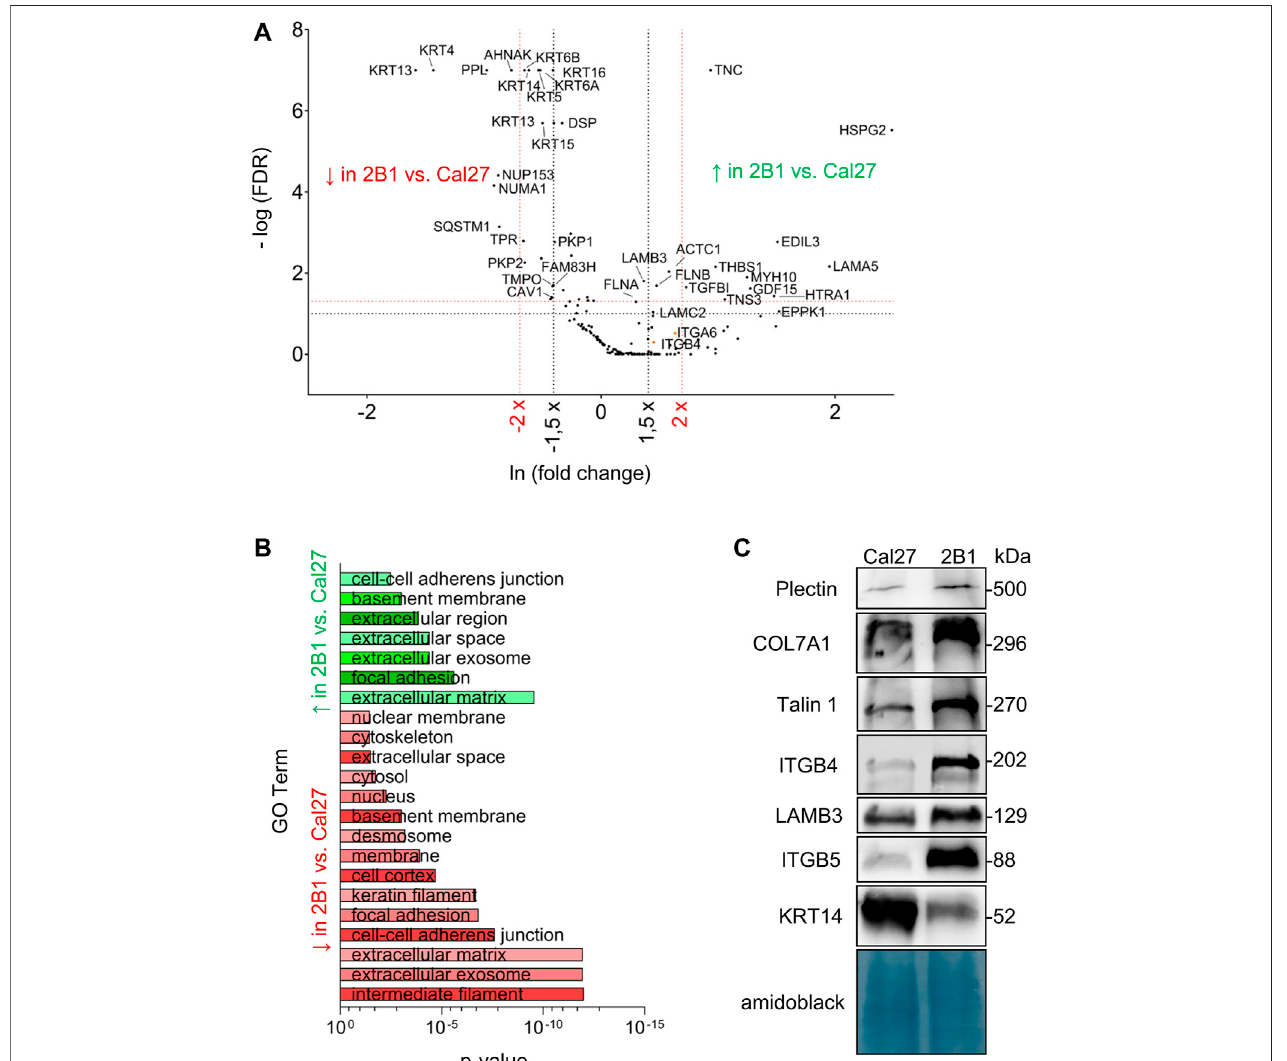
FIGURE2| Analysisand validationofIACs isolatedfrom Cal27 cellsand clone 2B1. (A) Volcano plotanalysis ofproteins detectedinIACs isolatedfrom Cal27 cells versus clone 2B1. IAC proteins from Cal27 and 2B1 cells are visualized as volcano plot after the analysis with QSpec/QProt to generate -Log (FDR) and fold change values.Cutoffvaluesof − Log(FDR) ≥ 1(redhorizontaldottedline)correspondingtoFDR ≤ 0.05and − Log(FDR) ≥ 1,3(blackhorizontaldottedline)correspondingtoFDR ≤ 0.1; and foldchange ≥ 1.5 (black vertical dotted line) or 2(red verticaldotted line) wereused. Each dot on the plot represents 1protein. Proteins with signi fi cantly different abundance between IACs of Cal27 and 2B1 cells, and of interest for this paper are marked with their gene name. Upper left quadrant – proteins detected with lower levels of spectra in 2B1, upper right quadrant – proteins detected with higher levels of spectra in 2B1, compared to Cal27. For this analysis, only proteins identi fi ed with a minimal number of spectral counts ≥ 4 in at least three out of fi ve biological replicates in either of Cal27 or 2B1 set were used, FDR < 5%, probability for protein identi fi cation ≥ 99.9%werevisualized. (B) DAVIDGOanalysisofproteinsfrom (A) withFDR ≤ 0.1andfoldchange ≥ or ≤ 1.5,detectedwithhigher(green)andlower(red) abundances in 2B1 as compared to Cal27. Statistically signi fi cant GO terms were presented in reverse x -axis of p -value from lowest (top) to the highest signi fi cance (bottom). Green represents GO terms annotated to the proteins whose abundance is higher in 2B1 than Cal27, and red to reverse. The p -value represents Benjamini corrected p -value. (C) WBanalysisofIAC proteins fromCal27and2B1cells.Seventy-two hoursafter seeding,IACs wereisolatedandWB analysiswasperformed. The results presented are representative of two independent experiments yielding similar results. PLEC, plectin; COL7A1, collagen VII; TLN1, talin 1; ITGB4, integrin subunit β 4; LAMB3, laminin subunit β 3; ITGB5, integrin subunit β 5; KRT-14, keratin 14.